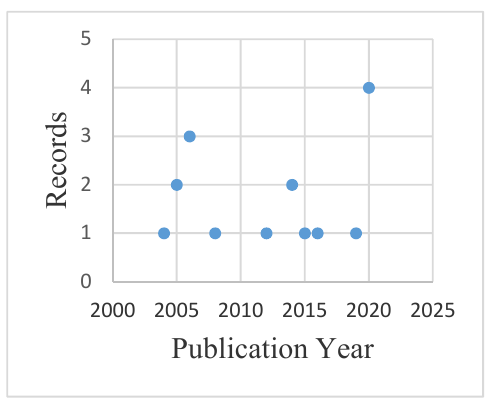
Figure 8. Publication trends in Section 2.